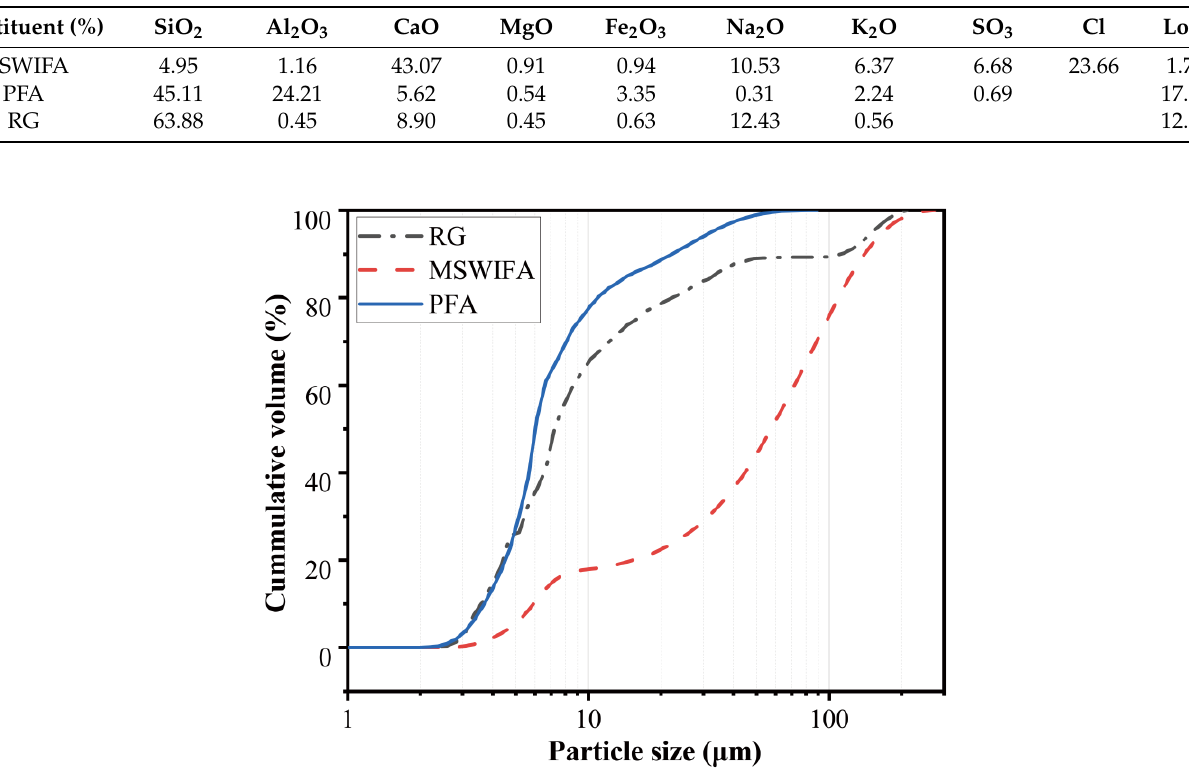
Figure 2. XRD patterns of raw materials (1-CaCO 3 (PDF#72-1653), 2-CaSO 4 (PDF#37-0184), 3- CaClOH (PDF#73-1885), 4-KCl (PDF#75-0298), 5-NaCl (PDF#88-2300), 6-SiO 2 (PDF#79-1906), 7-Mulite (PDF#84-1205)). Table 1. The chemical compositions of raw materials.